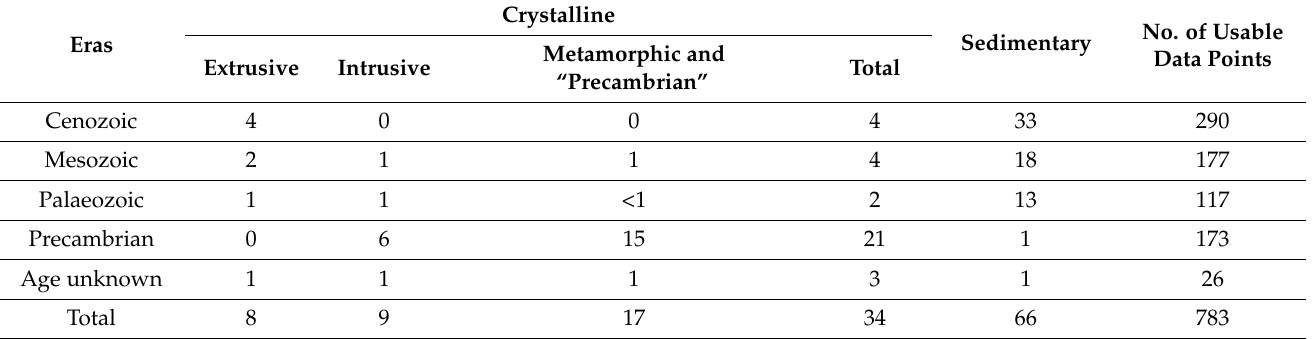
Table 2. Percentage of rock types exposed on Earth’s surface as function of geological age [47]. According to the table, extrusive and intrusive rocks are the rarest, while sedimentary rocks, especially Cenozoic, are the most common at the Earth’s